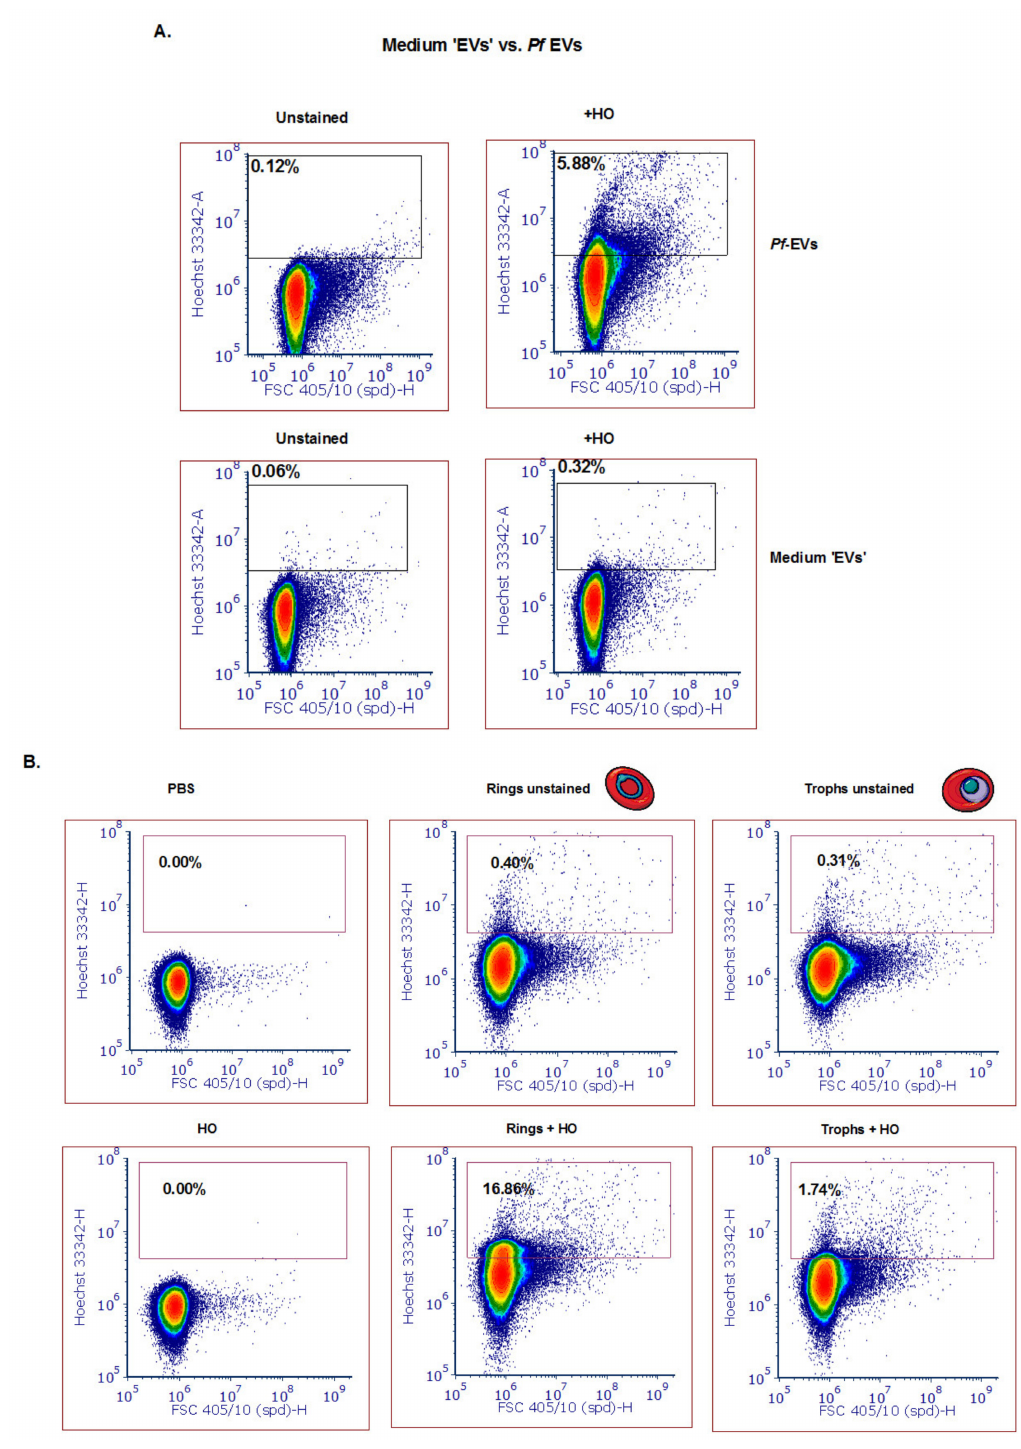
Figure 3. Detection of di ff erent subpopulations of Pf -derived EVs using the ZE5 analyzer. ( A ) Top row: Mixed population of Pf -derived EVs (ring and trophozoite) stained with HO. Gating was done according to the unstained EVs. Bottom row: medium-derived ‘EVs’ were used as a control for absence of DNA content. ( B ) Pf -derived EVs from di ff erent parasite stages (ring and trophozoite) were stained with HO to visualize the DNA inside the EVs. Gating was done according to the unstained EV